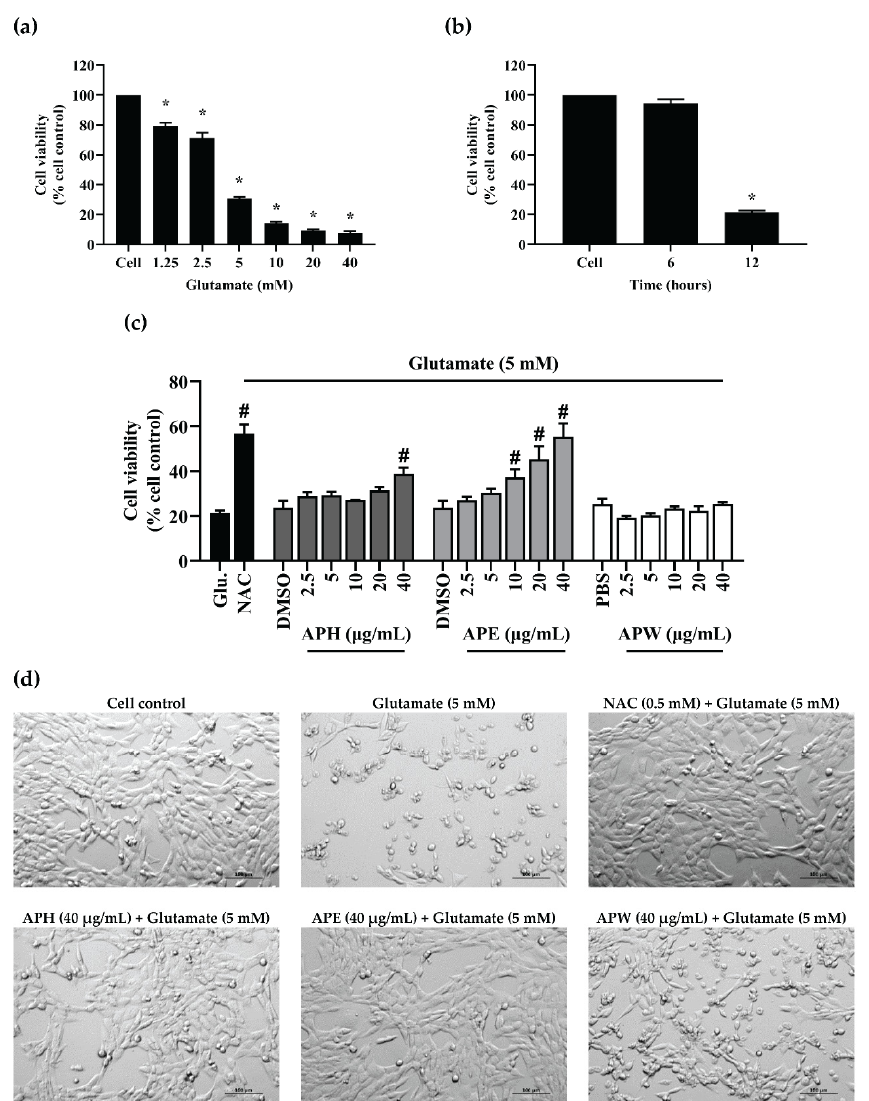
Figure 3. Glutamate-induced HT-22 hippocampal cell toxicity results. ( a ) Treatment of glutamate at various concentrations on HT-22 cells for 24 h. ( b ) Treatment of glutamate (5mM) on HT-22 cells for 6 and 12 h. ( c ) The effects of AP crude extracts: APH, APE, and APW on glutamate-induced HT-22 cells for 12 h. N -acetyl cysteine (NAC, 0.5 mM) was used as the positive control. DMSO (0.1%, v / v ) and PBS (0.1%, v / v ) were used as the vehicle control. All data are shown as the mean ± SEM of triplicate values. Statistical significance was analyzed by one-way ANOVA, Dunnett test. * p < 0.05 versus the cell control. # p < 0.05 versus the glutamate (Glu.) control. ( d ) Morphological changes of glutamate-induced HT-22 hippocampal cells after co-treatment with NAC (0.5 mM), APH (40 µg/mL), APE (40 µg/mL), or APW (40 µg/mL) for 12 h. The cells were observed under differential interference contrast (DIC) microscope at 5× magnification. The scale bar indicates 100 µm.